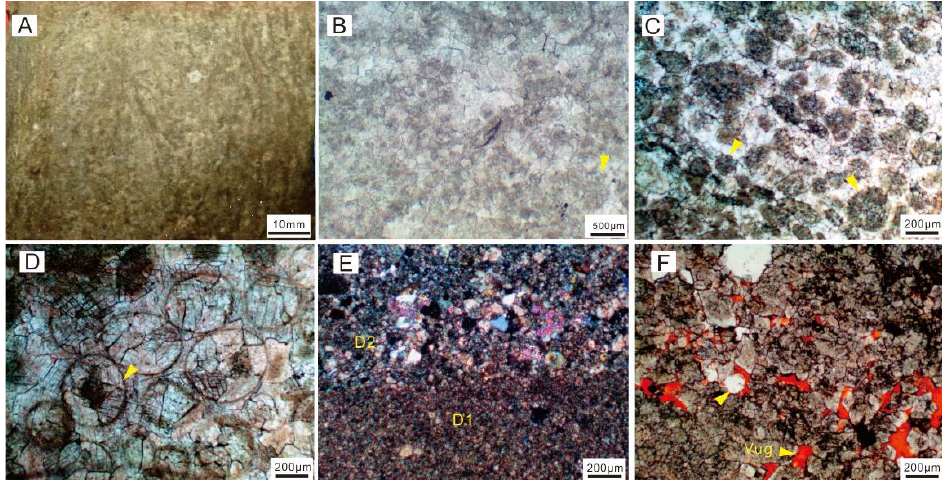
Figure 4. D2 dolomite: ( A ) Core photograph of fine-crystalline arenite dolomite, well HT1, 6437.30 m, Є 2 a. ( B ) Tightly packed dolomite crystals with curved surfaces show fuzzy allochem ghost (arrows), well BT5, 4802.66 m, Є3x, under PPL. ( C ) Ooid grains with cloudy cores and clear rims (arrows), well HT1, 6161.40 m, Є 2 a, under PPL. ( D ) Precursor deposit structure (granule ghost, arrows), well HT1, 6162.60 m, Є 1 x, under PPL. ( E ) Very fine-crystalline dolomite and fine-crystalline dolomite are distributed on different sides of the stylolite, well BT5, 5644.24 m, Є 1 w, under PPL. ( F ) Fine-crystalline dolomite crystals distributed around dissolution fractures, which are partially filled with calcite and pyrite (arrows), well BT5, 5787.63 m, Є 1 w, under